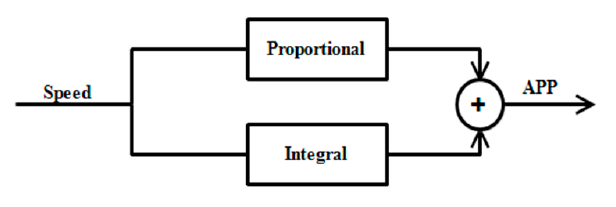
Figure 5. Driver